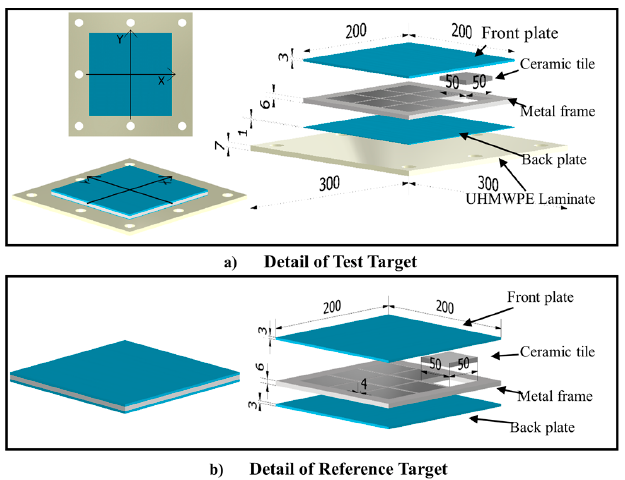
Figure 1. Schematic diagram of the test and reference targets. ( a ) Detail of Test Target. ( b ) Detail of Reference Target.